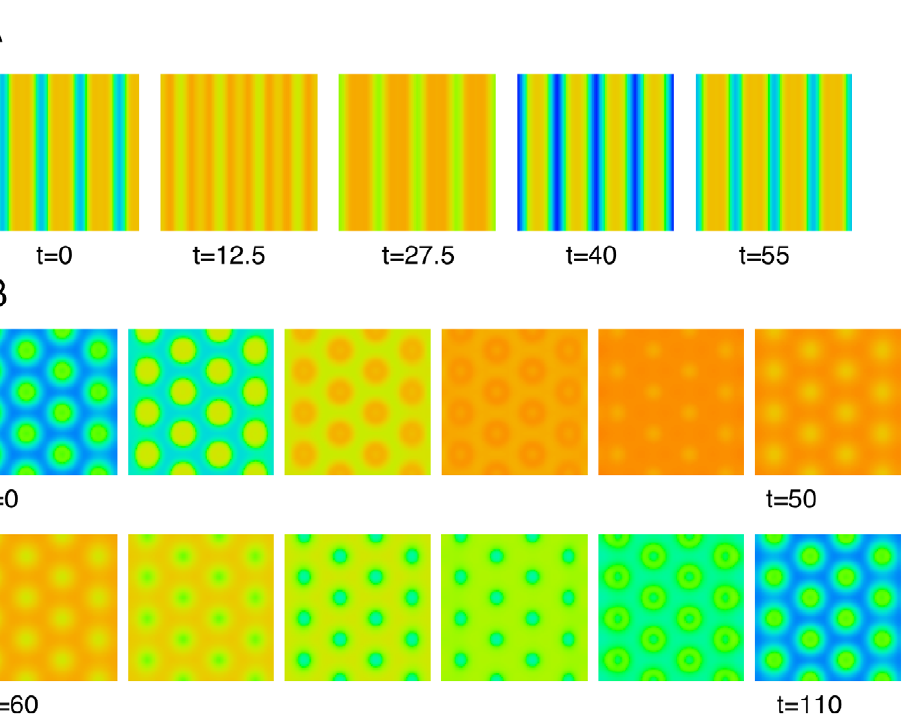
Figure 5. Time frames for different frequencies of stimulus. (A) high frequency stimulation (18.2 Hz); (B) low frequency (9.1 Hz) stimulation. Note that in (A) after one temporal cycle of 55 msec, the pattern is shifted by one half of a spatial cycle.